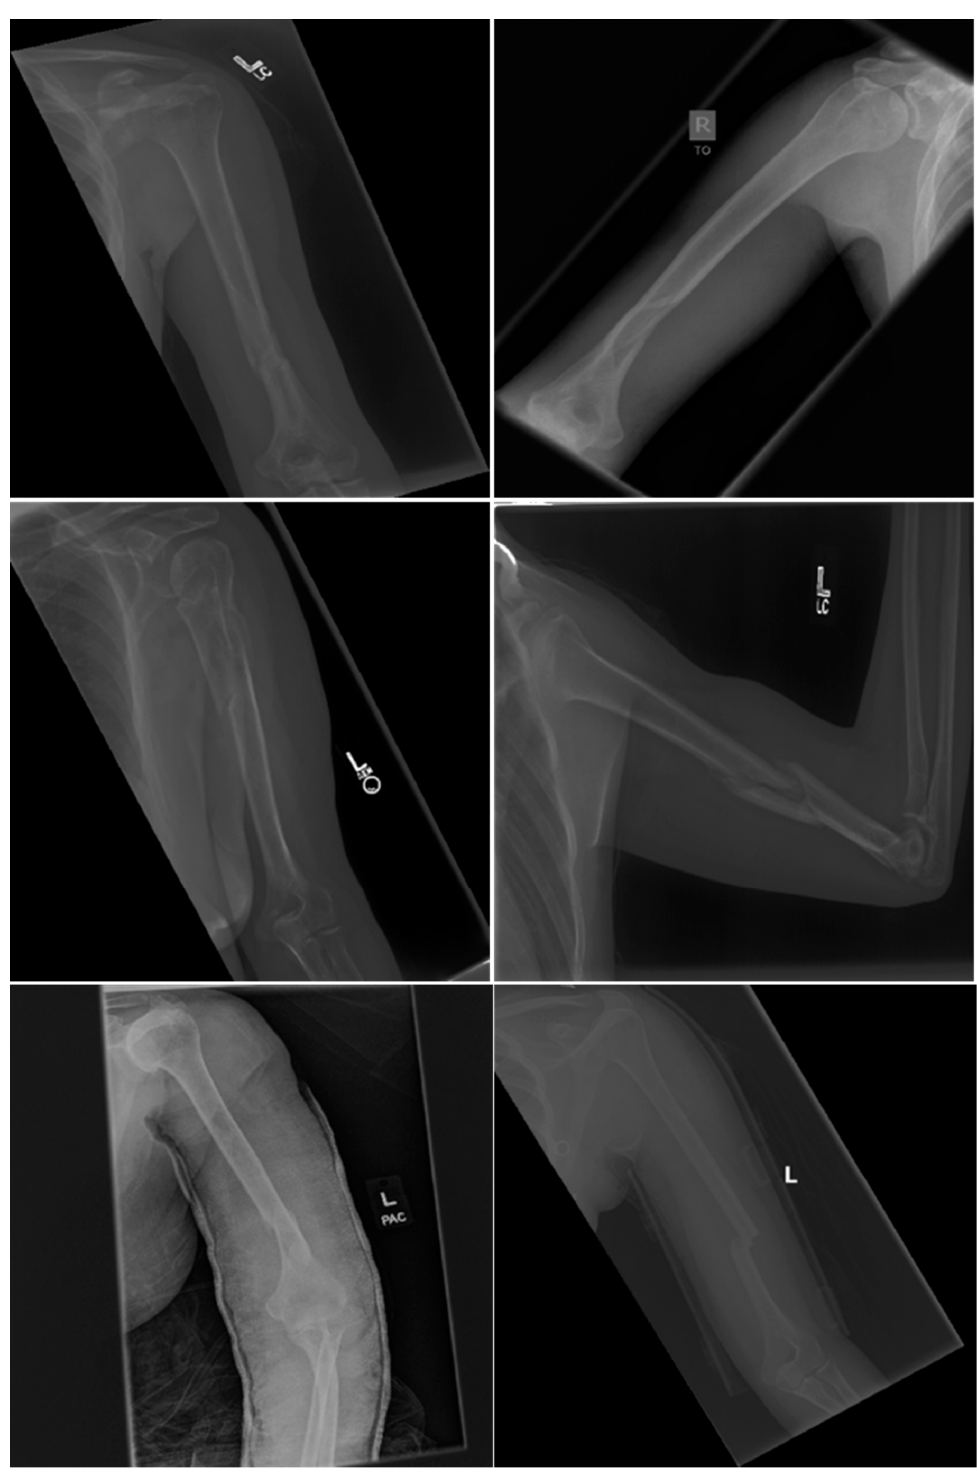
Figure 6. Examples of Humerus abnormalities correctly classified by DenseNet-201 and incorrectly classified by DenseNet-169.